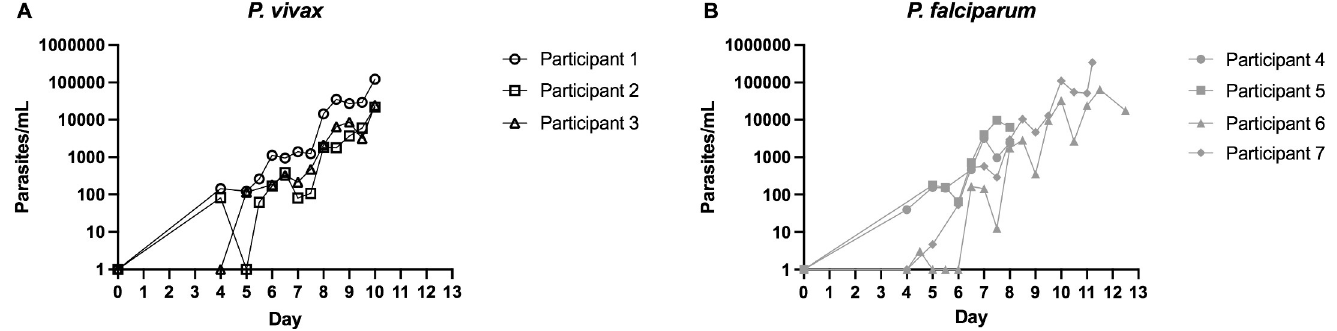
Fig 1. Parasitemia curves for participants inoculated with (A) P . vivax and (B) P . falciparum